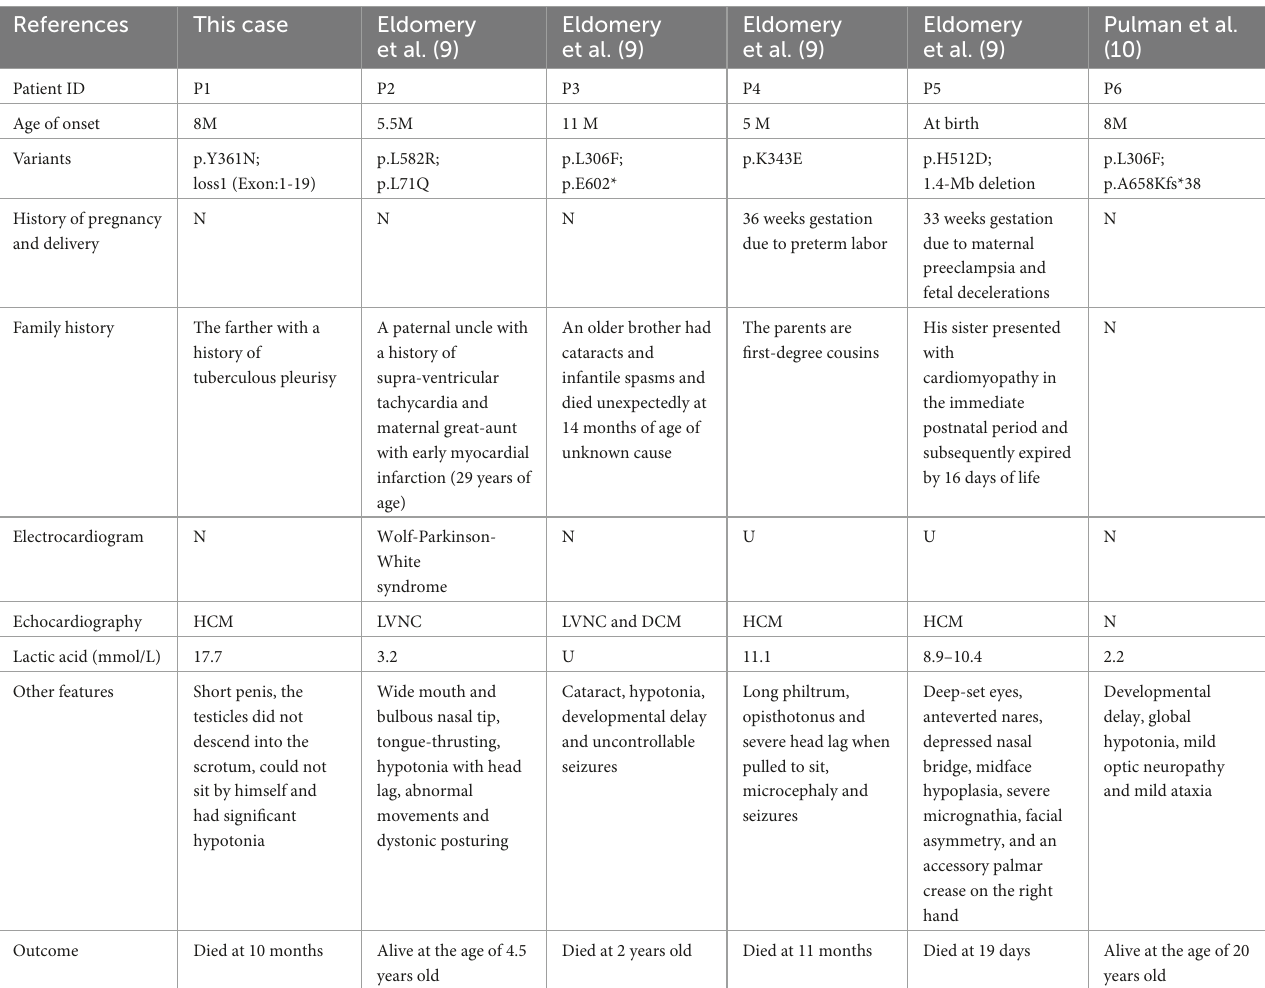
TABLE 1 The MIPEP gene variants in six unrelated patients from six unrelated